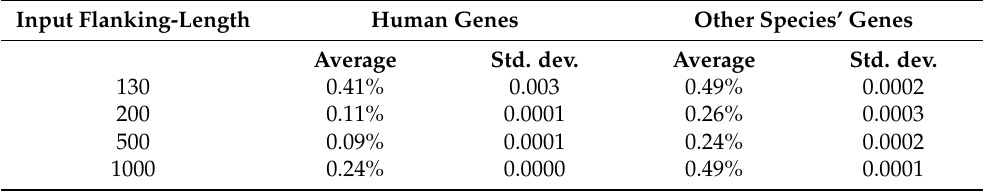
Table 3. Percentage of false positives with input genomic sequences with different flanking lengths.